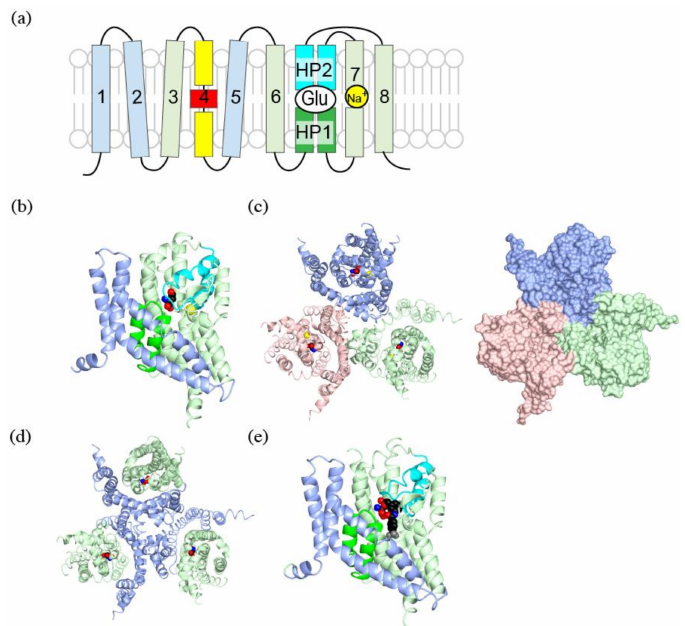
Figure 2. Crystal structures of a human EAAT1: ( a ) Topology diagram for SLC1 family transporters. The trimerization domain is in light blue; the transport domain is in light green; helical hairpin1 (HP1) is in green; HP2 is in cyan; and TM4 is in yellow and red; ( b ) A ribbon diagram of a human EAAT1 colored as in ( a ), with L-aspartate (spheres) and a sodium ion (yellow). PDBID:5LLU; ( c ) Ribbon (left) and surface (right) diagram of a human EAAT1 trimer viewed from extracellular face. Protomers of the trimer are colored in pink, light blue and light green; ( d ) Ribbon diagram of a human EAAT1 with the trimerization domain in light blue, and the transport domain in light green; ( e ) Ribbon diagram of a human EAAT1 with D , L -threo-b-benzyloxyaspartate (TBOA) (spheres) as shown in ( b ). Notice that the tip of HP2 (cyan) is open and does not cover TBOA. PDBID:5MJU. Pictures are generated using QtMG